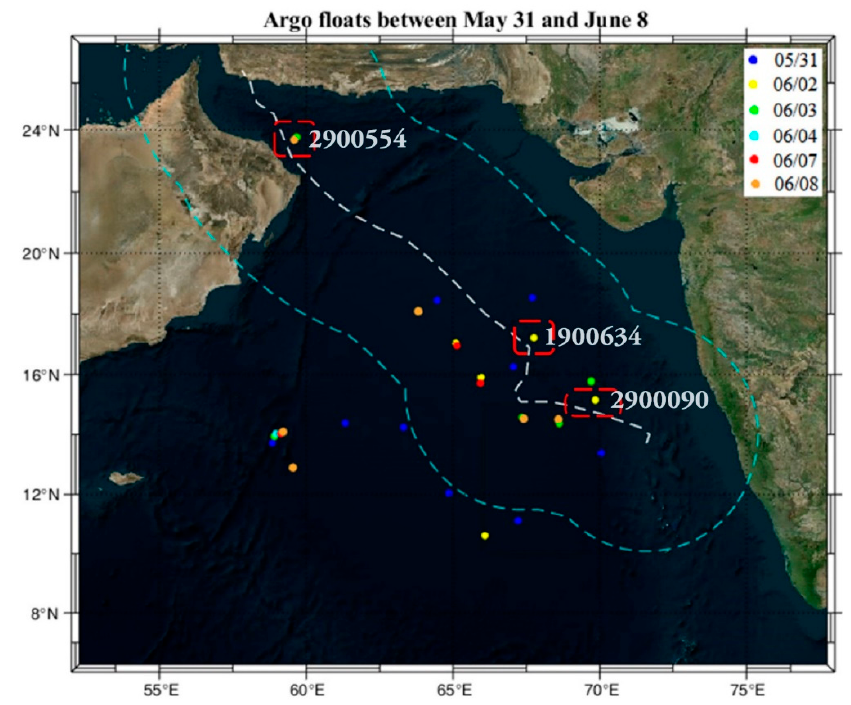
Figure 12. Locations of Argo profilers used for evaluations.